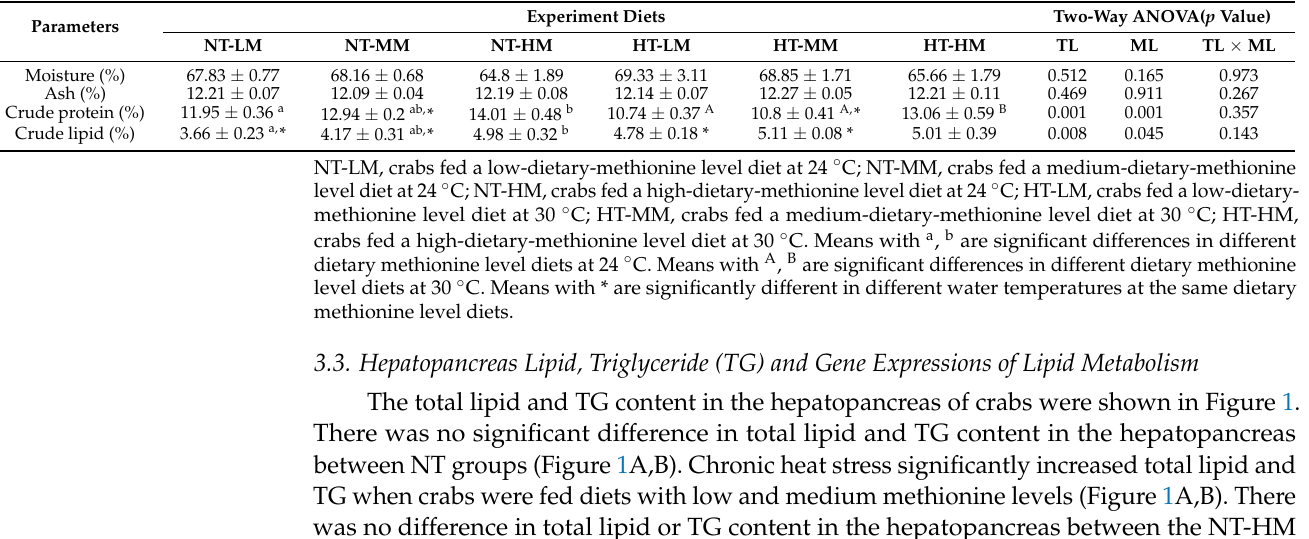
Table 5. Proximate composition of juvenile E. sinensis fed different experimental diets (mean ± SEM) ( n = 4 replicate